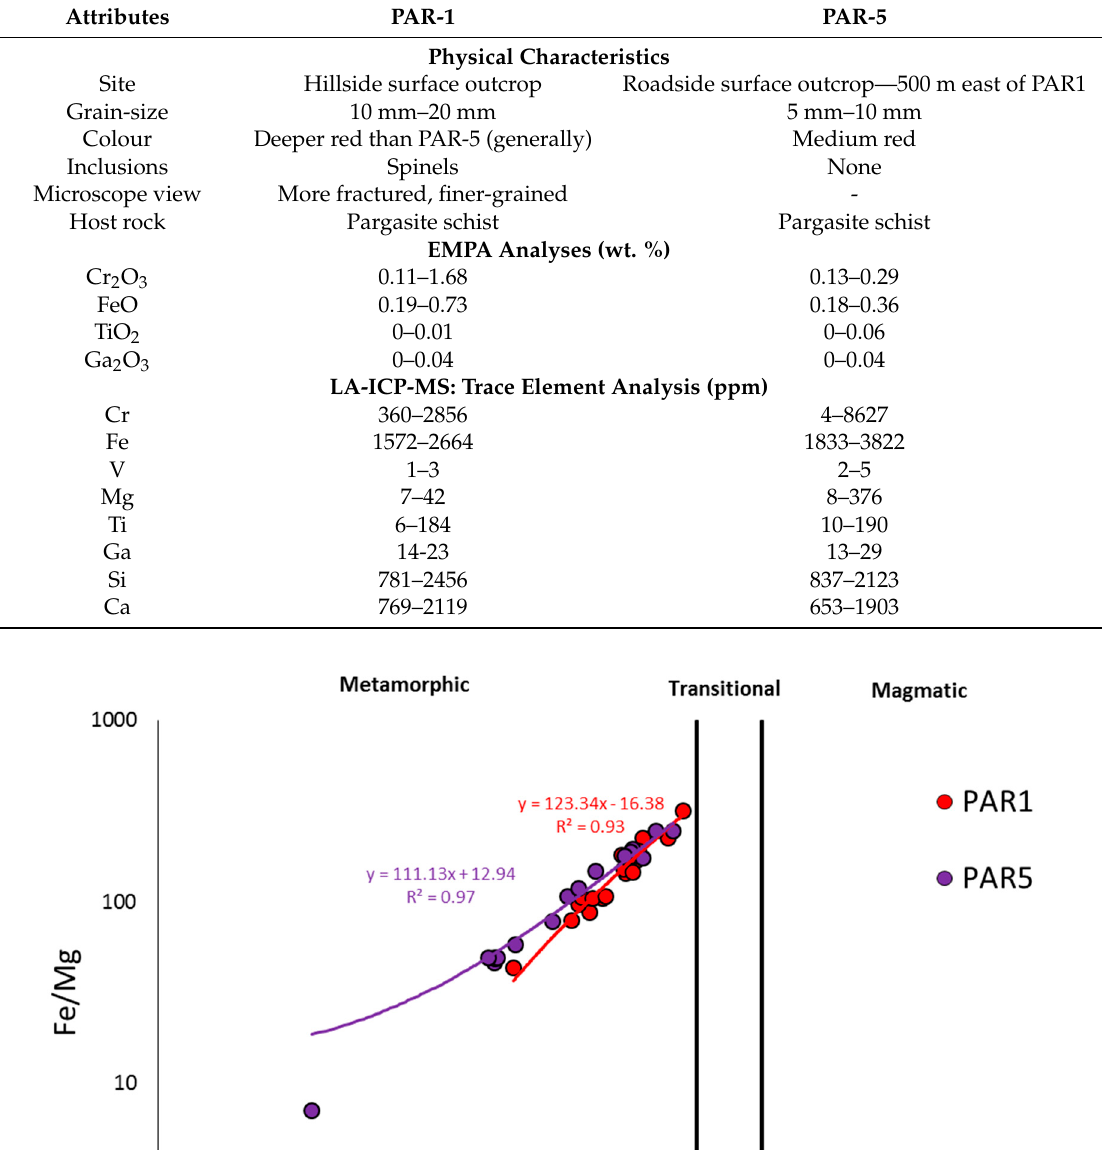
Table 1. Summary of prior Paranesti ruby results (Wang et al. 2017 [18]).